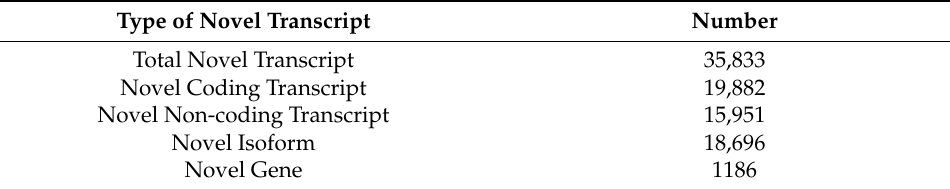
Table 3. Summary of novel transcripts identified from all